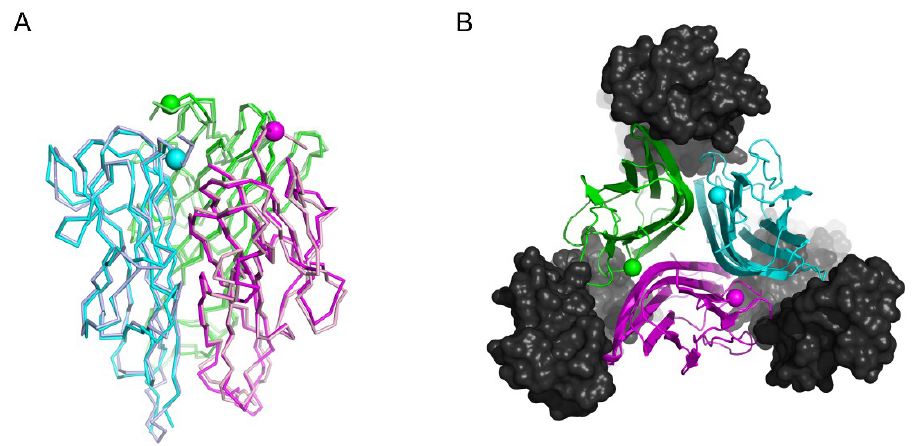
Figure 1. Conformational features of NGR-hTNF monomer. ( A ) Crystal structure of the NGR-hTNF trimer (PDB ID 6RMJ, with individual chains of the trimer colored darker shades of blue, pink, and green) superimposed with hTNF (PDB ID 1TNF, individual chains colored in lighter shades), underscoring the high similarity between the two proteins ( B ) Superposition of the NGR-hTNF structure (in color) onto the crystal structure of the LT α -TNFR1 complex (black, PDB ID 1TNR). In both panels, the first ordered residue in the crystal structure of NGR-hTNF in each chain, Ser9, is shown as a sphere. The N-terminal extension can extend into the solvent without interfering with receptor binding.